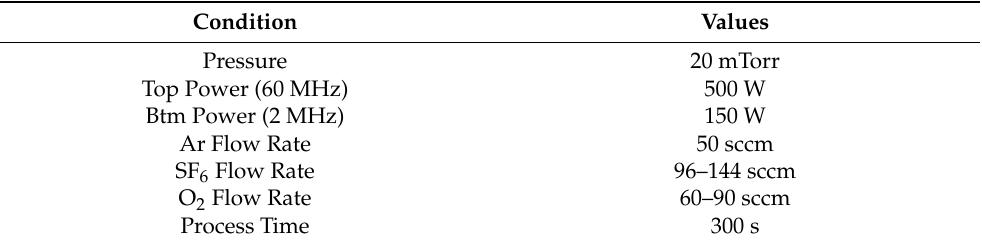
Figure 1. Schematic diagram of the CCP chamber used for Si etching. SF 6 , O 2 , and Ar are delivered through the MFC, and the pressure inside the chamber is maintained at 20 mTorr by the throttle valve. The VHF power of 60 MHz is delivered to the top electrode, and the LF power of 2 MHz is delivered to the bottom electrode. The emitted light of the plasma is observed through the OES sensor in which the viewport is located on the outer wall of the chamber. Table 1. Etch process conditions to acquire the data for PI-VM for the etch profile (PI-VM (etch profile))